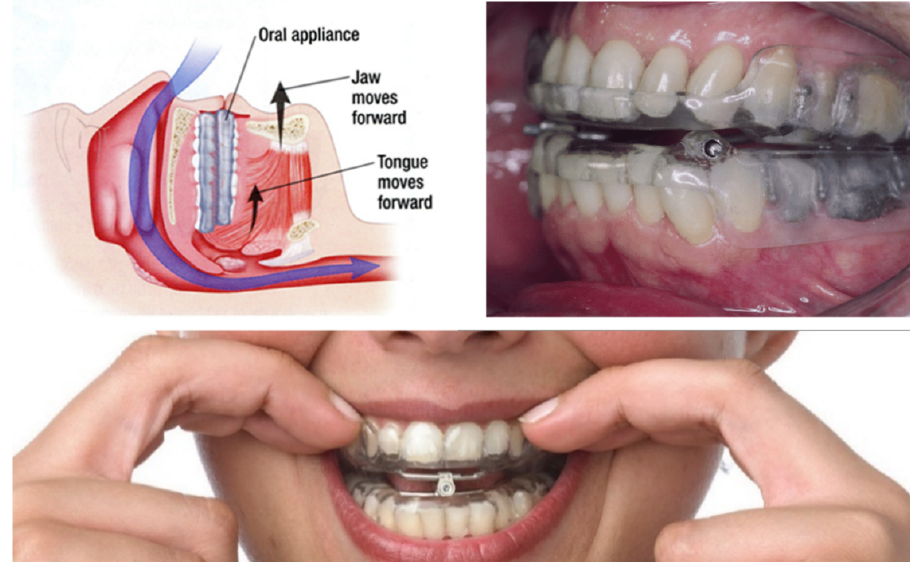
Figure 2. MAD [12] for treating